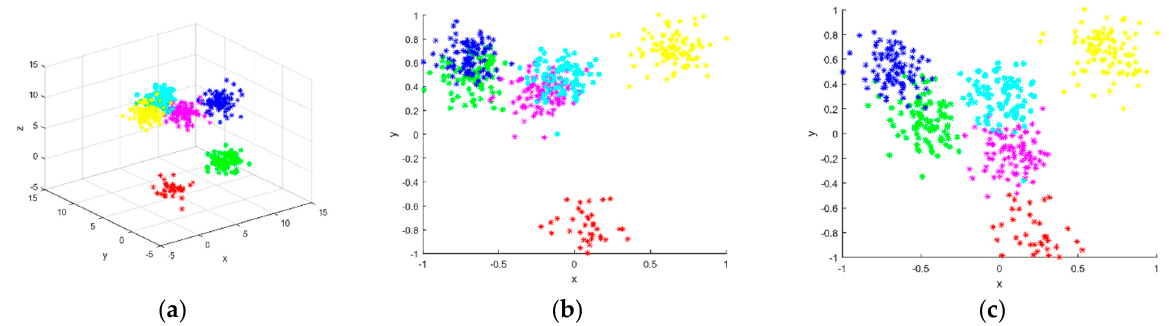
Figure 2. Visualizations of subspaces obtained upon “3d_clusters” toy dataset: ( a ) Original data; ( b ) LPP; ( c ) Proposed + LPP, ( x y and z represent the features; LPP: Locality Preserving Projection).